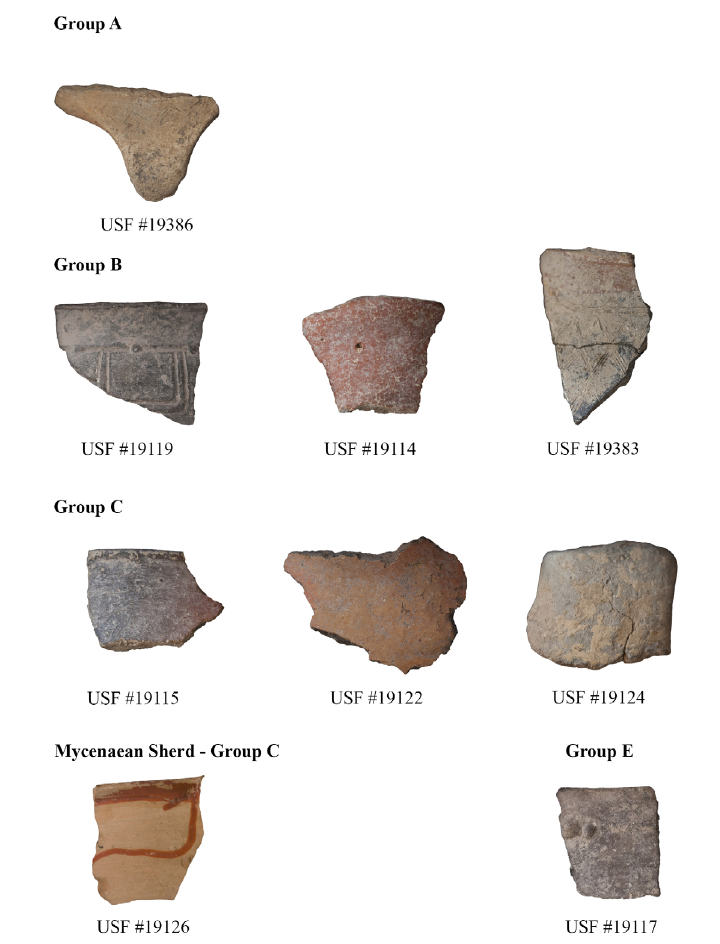
Figure 9 . Selection of sherd examples from the Borġ in-Nadur phase and group assignments based on the principal compo- nent analysis depicted in Figure 5 (Not to scale). Sherds, Vessels and Figurines Photograph by Fred